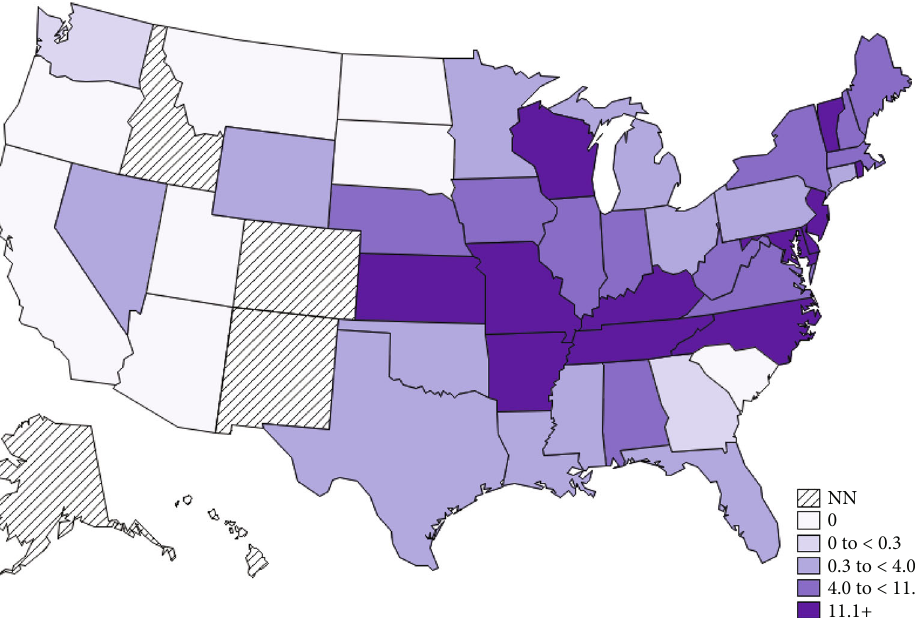
Figure 1: Annual incidence (per million population) of HME in the United States in 2019. This graph shows the general distribution and incidence of HME in the United States, with most cases occurring in the south-central and southeastern United States. Courtesy of the Centers for Disease Control and Prevention